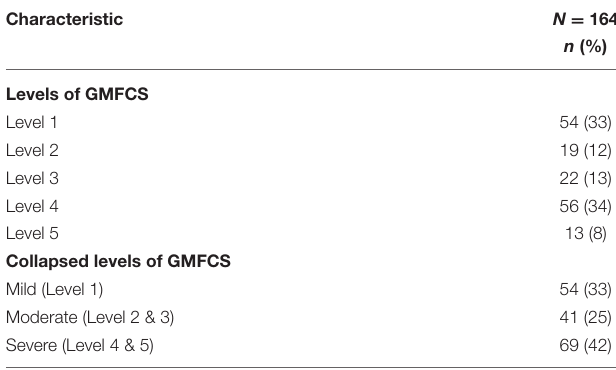
TABLE 5 | GMFCS breakdown in CP